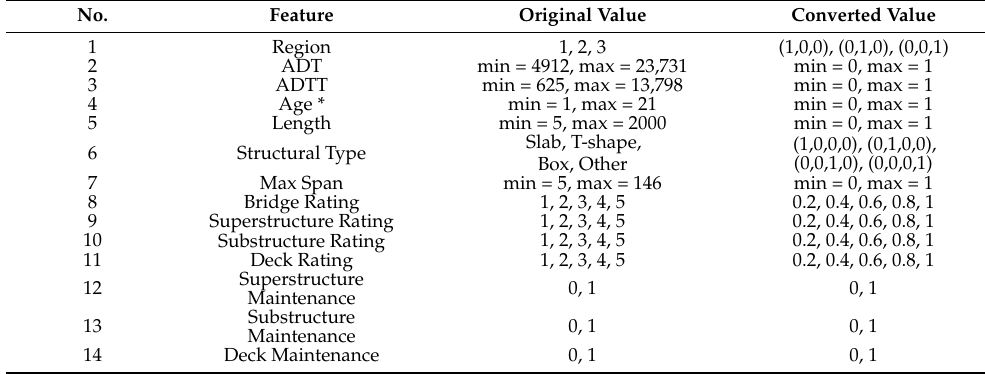
Table 2. Selected features and their data value